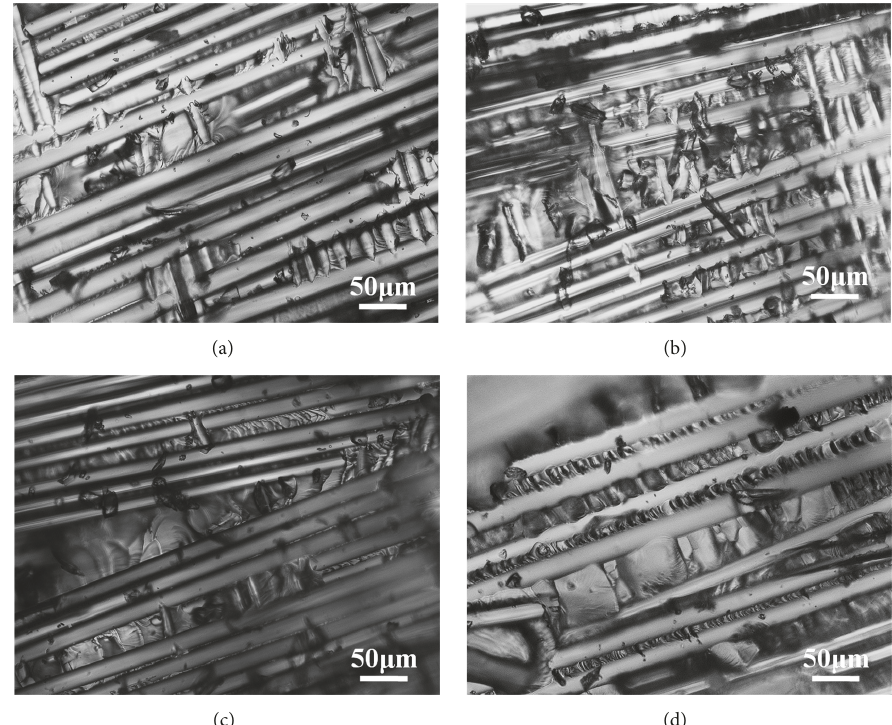
Figure 10: Micrographs of the longitudinal section ( × 50) of stressed specimens: (a) SWD2 after 60 WD cycles; (b) SWD2 after 180WD cycles; (c) WWD2 after 180WD cycles; and (d) WWD4 after 180 WD